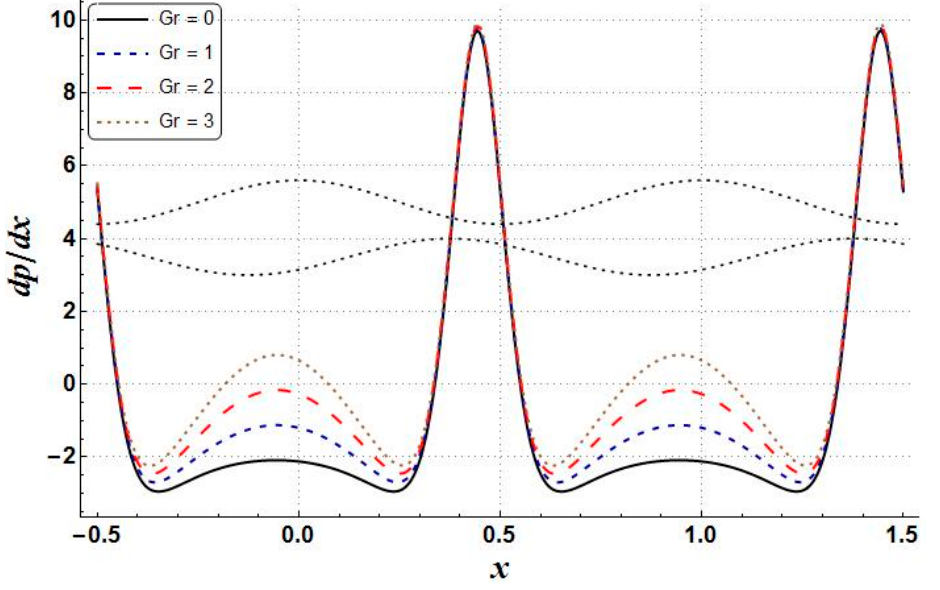
Figure 20. Influence on dp φ = 0.05, k = 2, a = 0.6, M = 1, d = 0.7, Br = 0.2, b = 0.5, m = 1, η = 0.8.